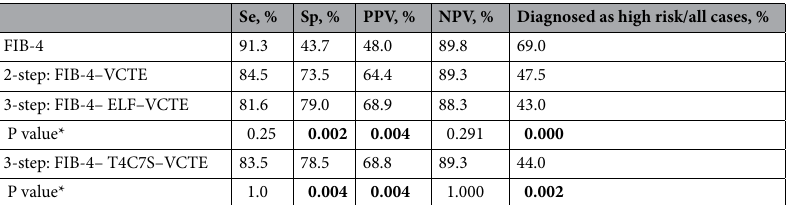
Table 2. Diagnostic performance of each approach for predicting advanced fibrosis in a tertiary care cohort with a high prevalence of advanced fibrosis. Bold indicates significance. ELF, enhanced liver fibrosis test; FIB-4, Fibrosis-4 index; NPV, negative predictive value; PPV, positive predictive value; Se, sensitivity; Sp, specificity; T4C7S, type IV collagen 7S domain; VCTE, vibration-controlled transient elastography. *P-value for comparison to 2-step